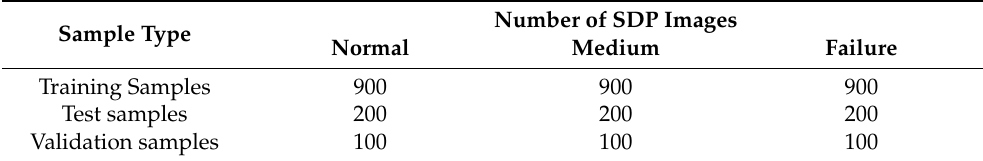
Table 9. SDP image